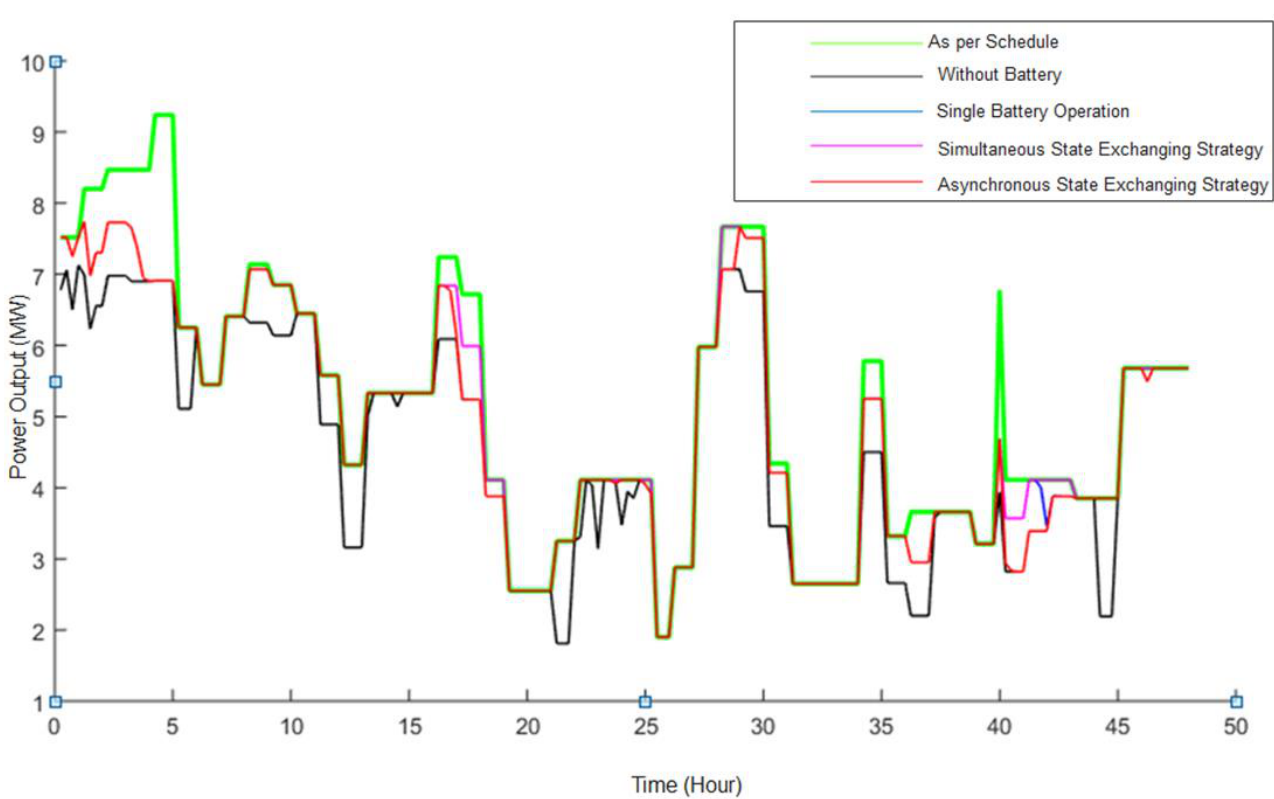
Figure 12. Power curve of output of BESS-integrated wind farm when 3 MW of battery.